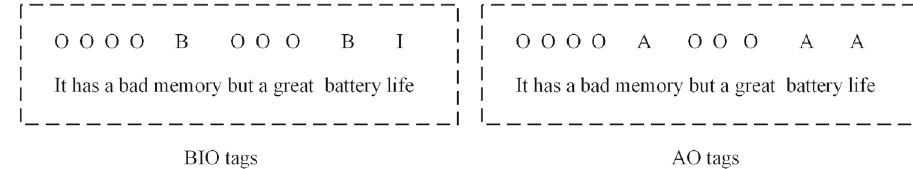
Fig. 6 The difference between BIO tags and AO